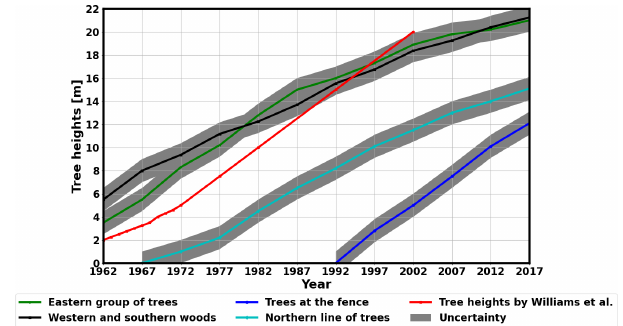
Figure 3. Time-dependent tree heights at